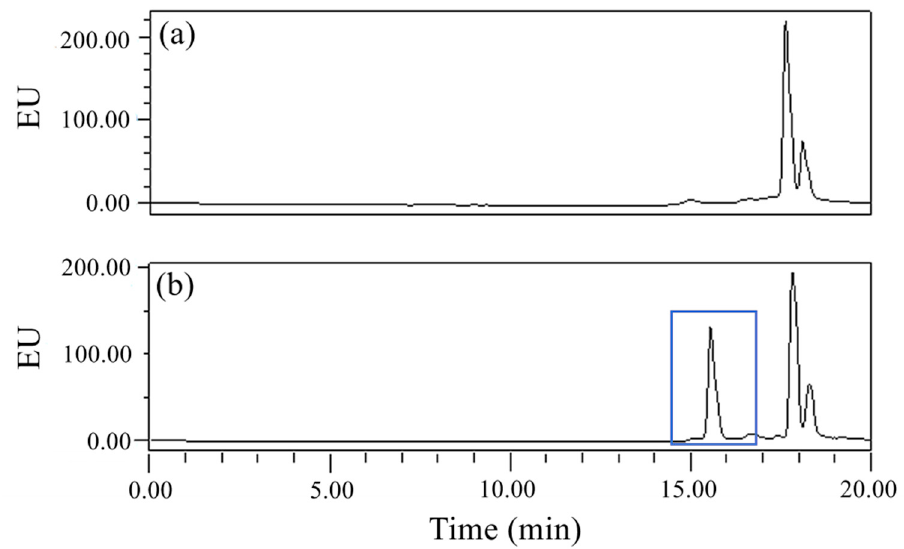
Figure 3. Chromatograms for ( a ) samples derived from the control sample and ( b ) 0.1 mg/L standard solution of GLUF-P.